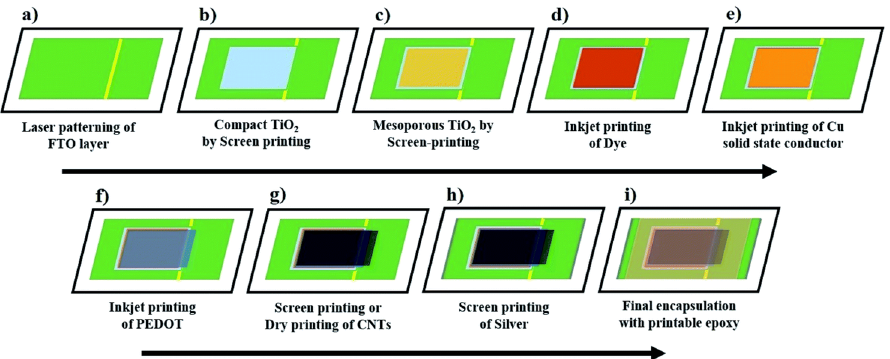
Figure 2. Proposed process flow for producing advanced monolithic DSSCs with Cu redox shuttle- based electrolytes and solid hole conductors [25]. (Reproduced from Ref. [25] 10.1039/D1TA00690H with permission from the Royal Society of Chemistry, under the terms of the CC BY [3.0] license.)